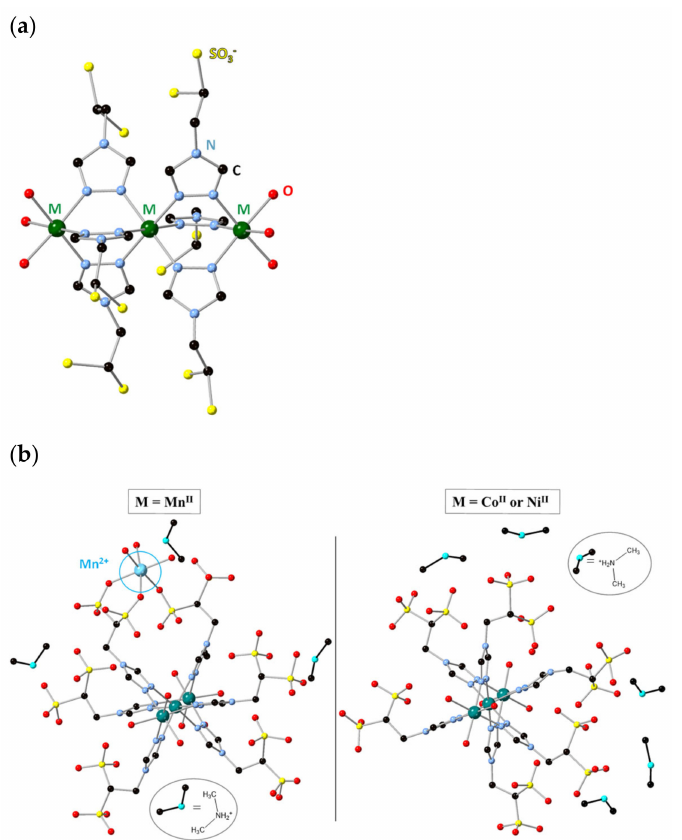
Figure 1. ( a ) Chemical structure of the polyanionic part for all the complexes. Oxygen atoms from the sulfonated groups were omitted for clarity. ( b ) Representation of the anionic part with countercations. Hydrogen atoms are omitted for clarity. Dimethyl ammonium cations (disordered) are represented only in one of their crystallographic